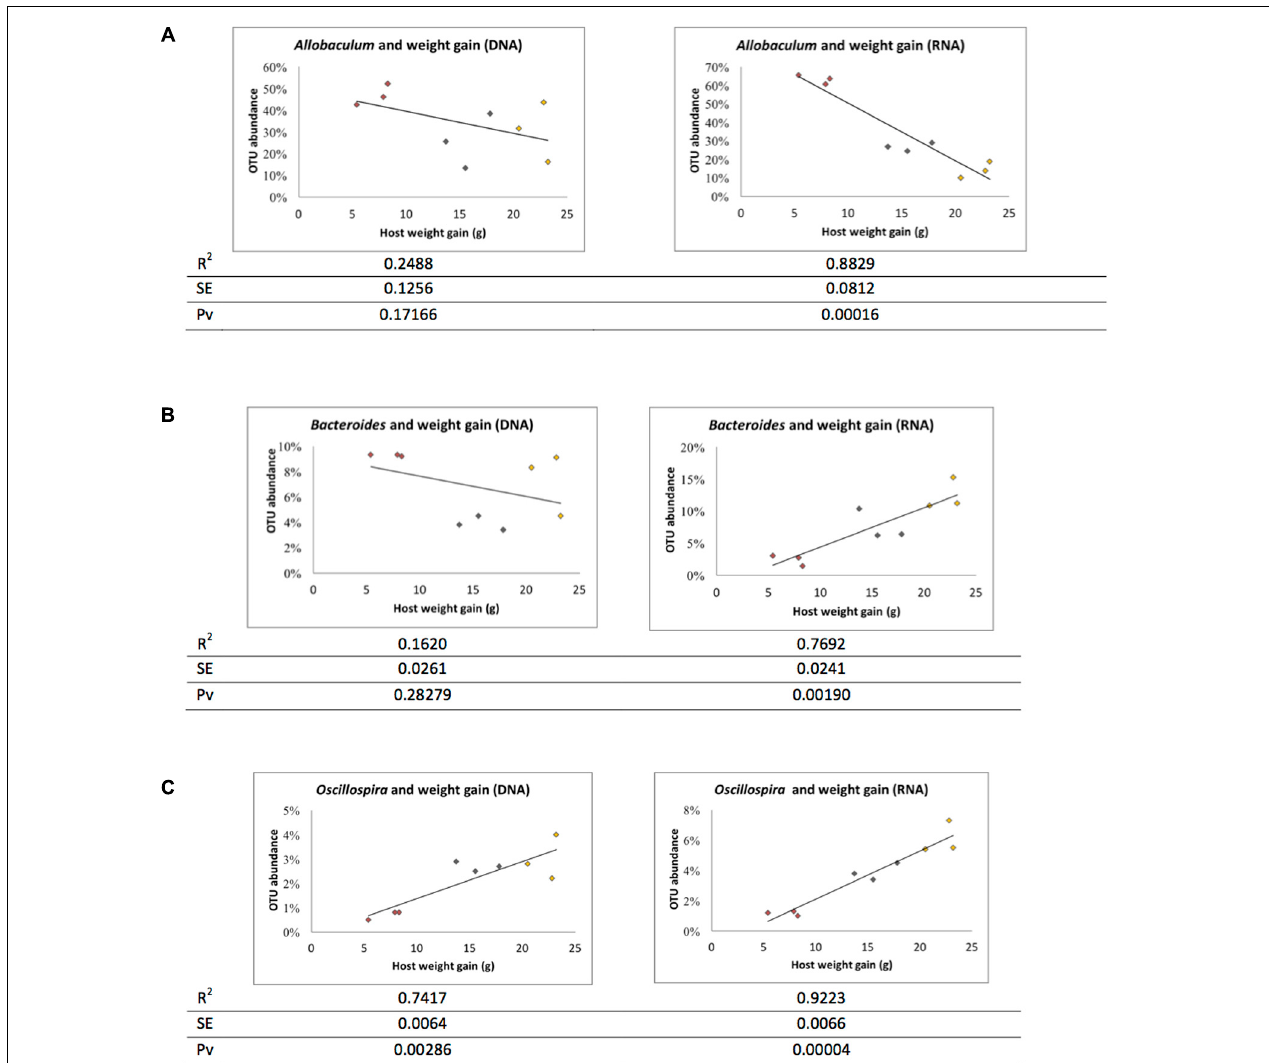
FIGURE 7 | Correlation between microbiota and weight gain. Correlation graph and R square ( R 2 ), standard error (SE) and Pearson correlation coefficient p -value (Pv) were derived based on weight gain. (A) Allobaculum , (B) Bacteroidetes, and (C) Oscillospira . Red: LFD; orange: HFD; black: